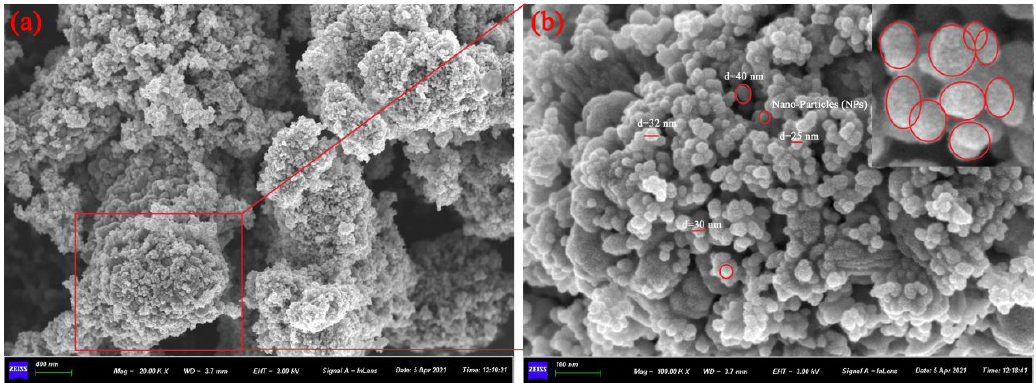
Figure 2. SEM images of ZnO NPs. ( a ) agglomeration, ( b ) nano-particles. XRD pattern analysis: Figure 3a shows the XRD patterns of the ZnO NPs, which are consistent with the data in PDF no. 01-070-8070. The crystal structure and phase purity of the sample are demonstrated. The diffraction peaks at 2 θ = 31.8 ◦ , 34.4 ◦ , 36.3 ◦ , 47.6 ◦ , 56.6 ◦ , 62.9 ◦ , 66.4 ◦ , 68.0 ◦ , 69.1 ◦ , and 72.6 ◦ correspond to the (100), (002), (101), (102), (110), (103), (200), (112), (201), and (004) crystallographic planes, respectively. The sharp peaks imply a